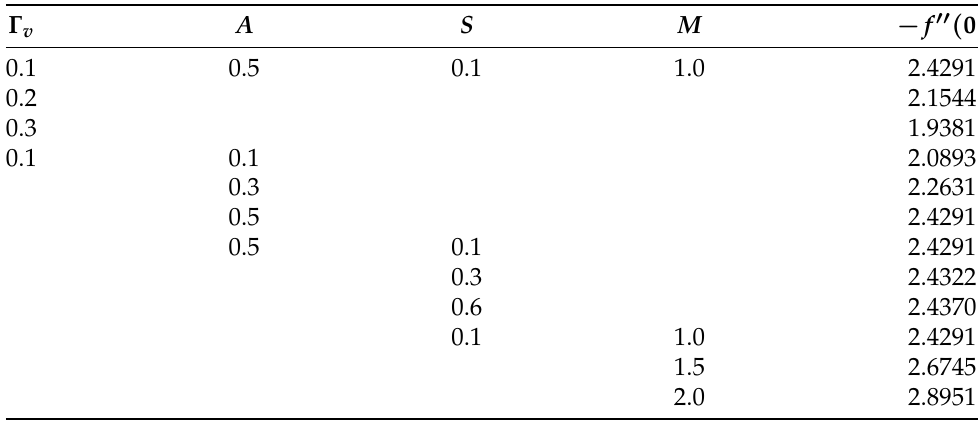
Table 3. Results for − f (cid:48)(cid:48) ( 0 ) in